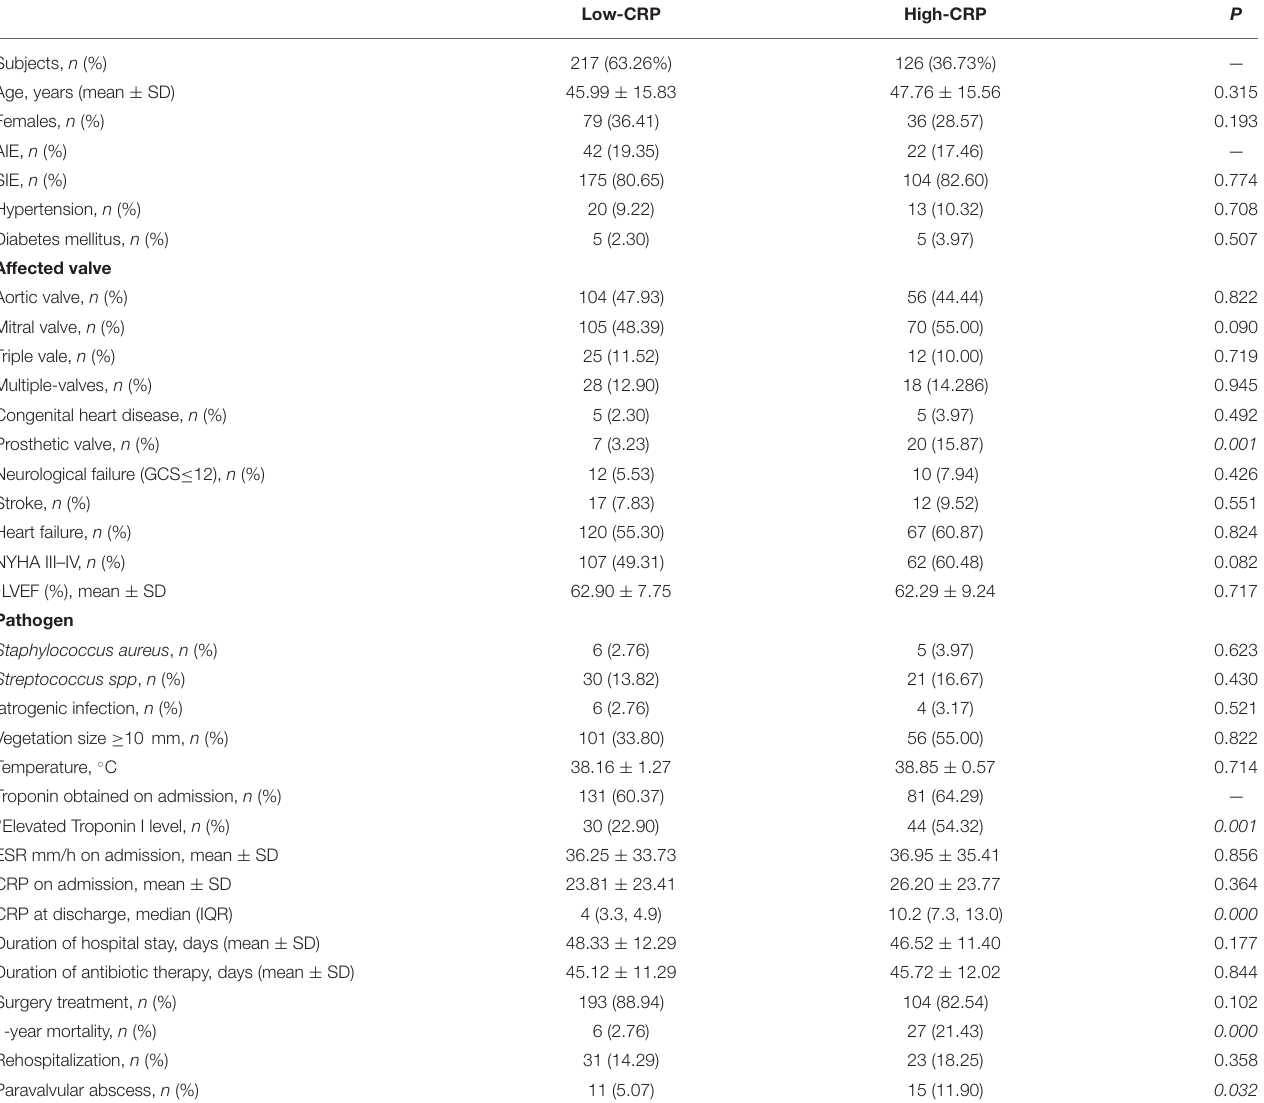
TABLE 1 | Baseline clinical characteristics of patients according to CRP group.